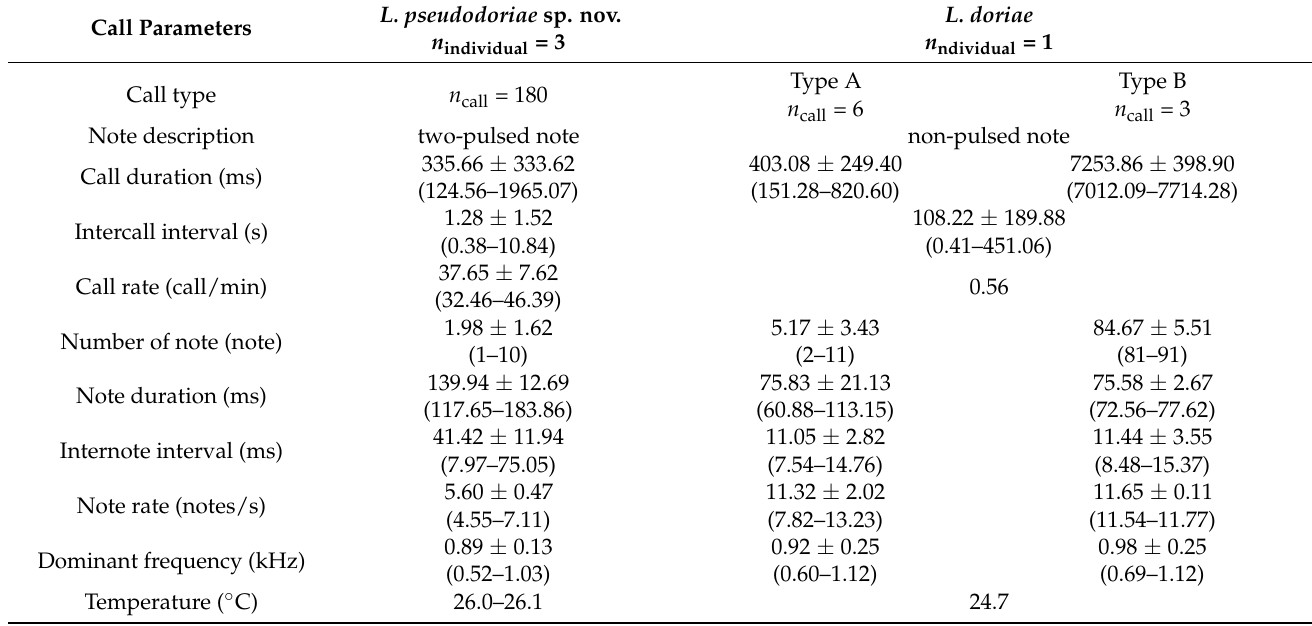
Table 5. Call parameters of Limnonectes pseudodoriae sp. nov . and L. doriae. Parameter values are given as mean ± SD and ranges in